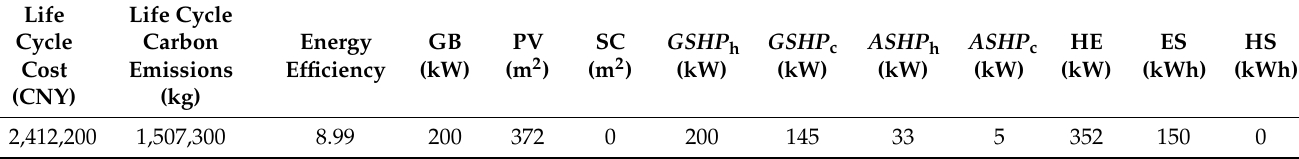
Table 6. Final decision scheme of the